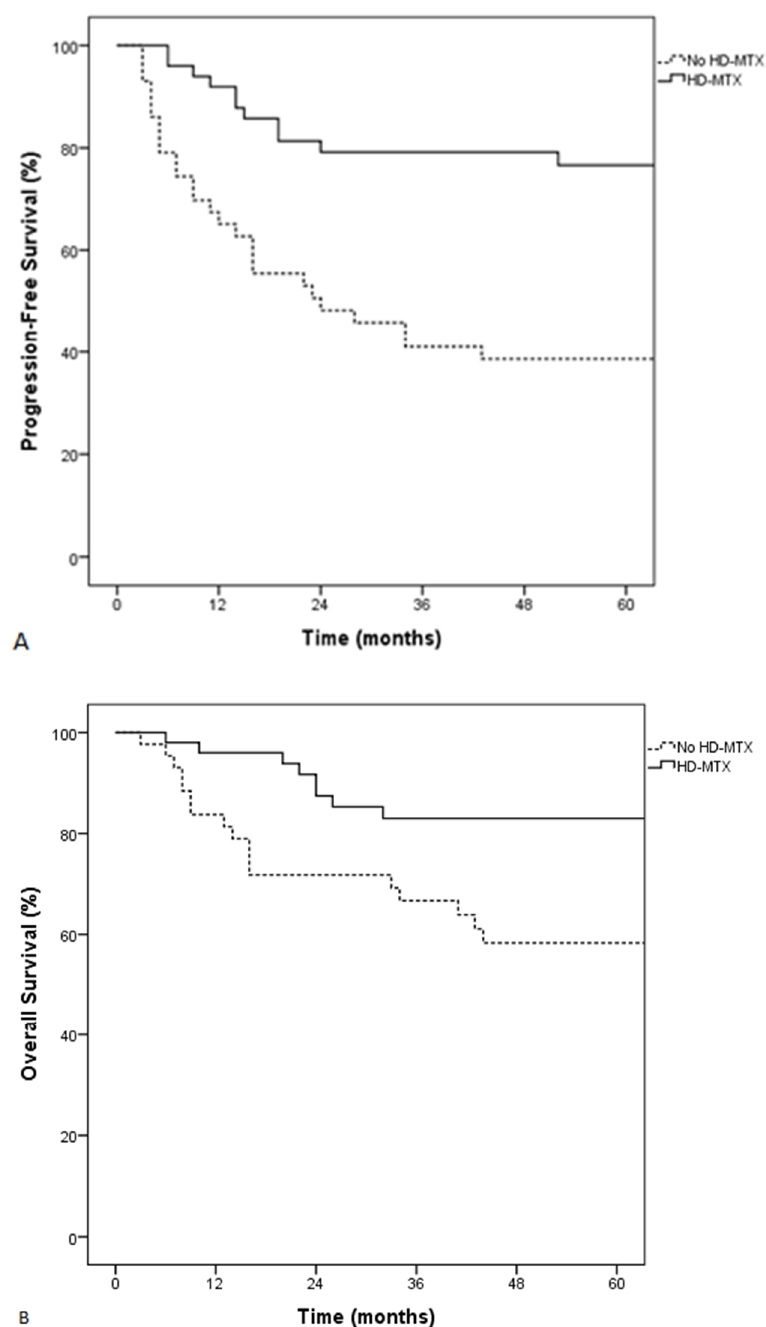
Figure 2. Progression-free survival (PFS) ( A ) and overall survival (OS) ( B ) of patients treated with or without HD-MTX.